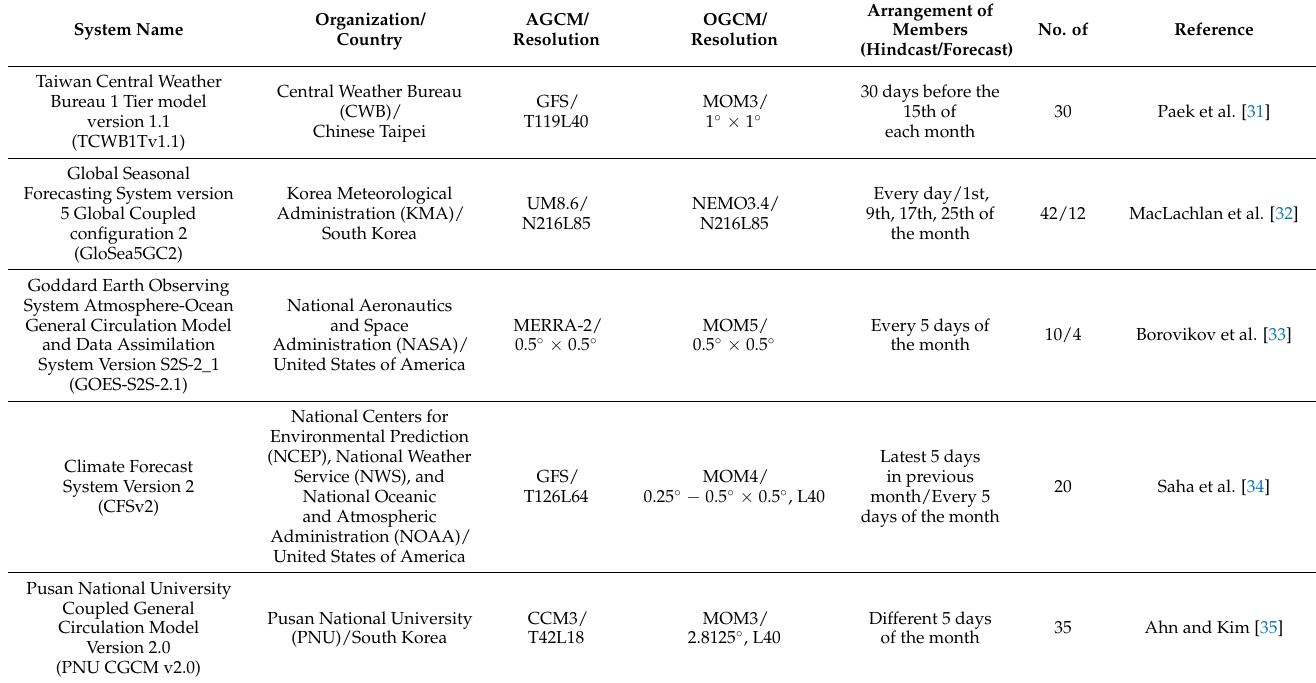
Table 1. Configurations of the